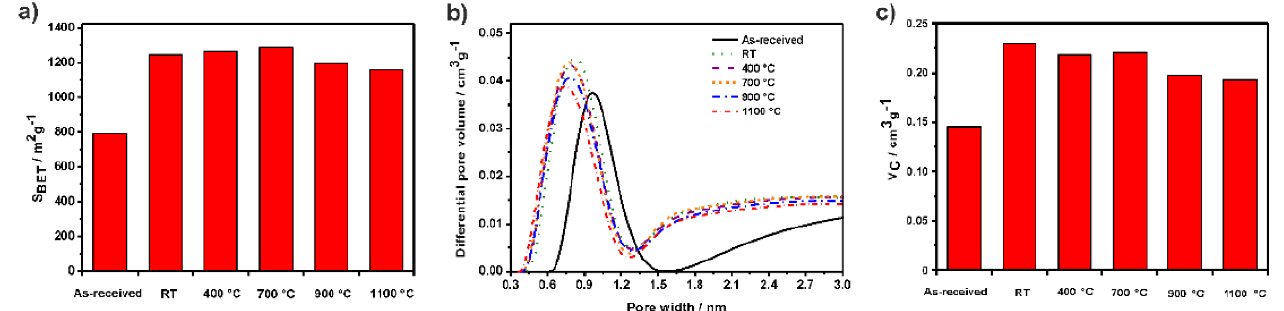
Figure 9. ( a ) S BET , the apparent specific surface area. ( b ) Nonlocal density functional theory (NLDFT) pore size distribution. ( c ) V C , cumulative volume for as–received, purified (RT) and annealed